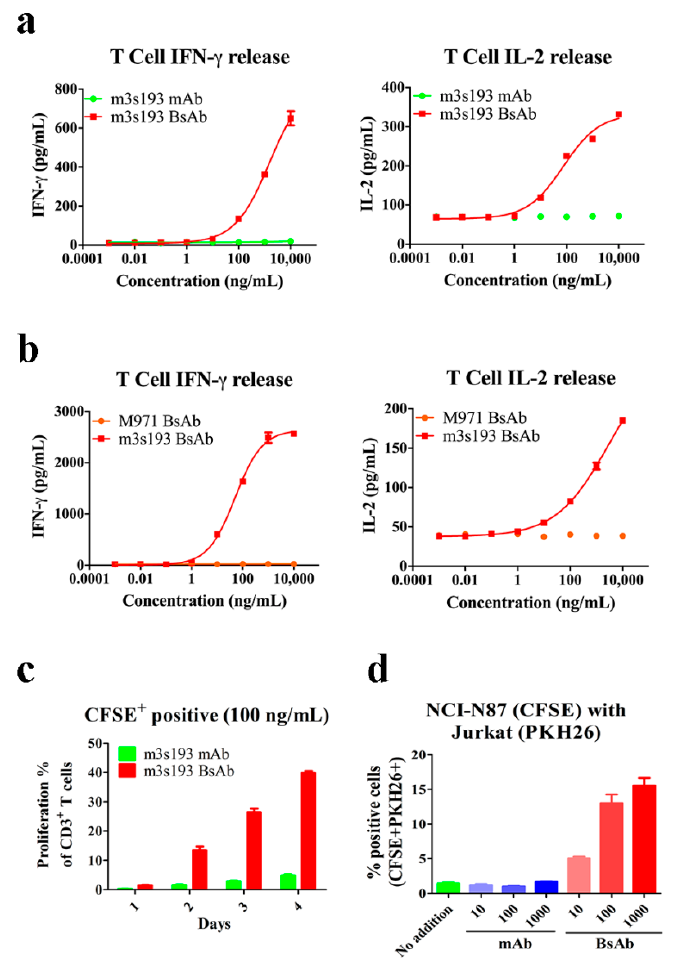
Figure 4. Cytokines release, proliferation, and recruiting mediated by m3s193 BsAb. ( a ) Cytokines release after 20 h incubation. ( b ) Cytokines release after 25 h incubation. ( c ) Proliferation of CD3 + T cells with 100 ng/mL of m3s193 BsAb or mAb. ( d ) Cell–cell association mediated by m3s193 BsAb or mAb. Data are shown as means ± SD with three duplicates.